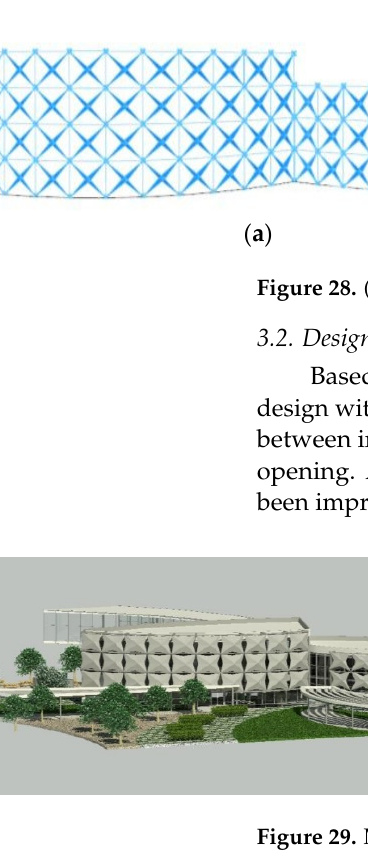
Figure 27. Details of the parametric dynamic façade.